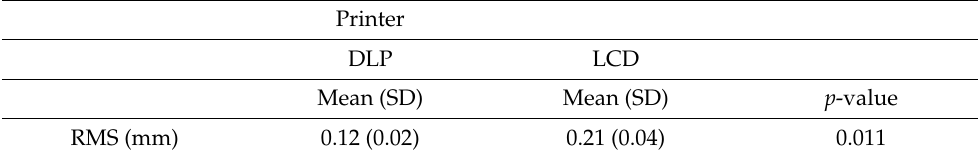
Figure 3. Boxplot of the distribution of RMS measurements by printer type.